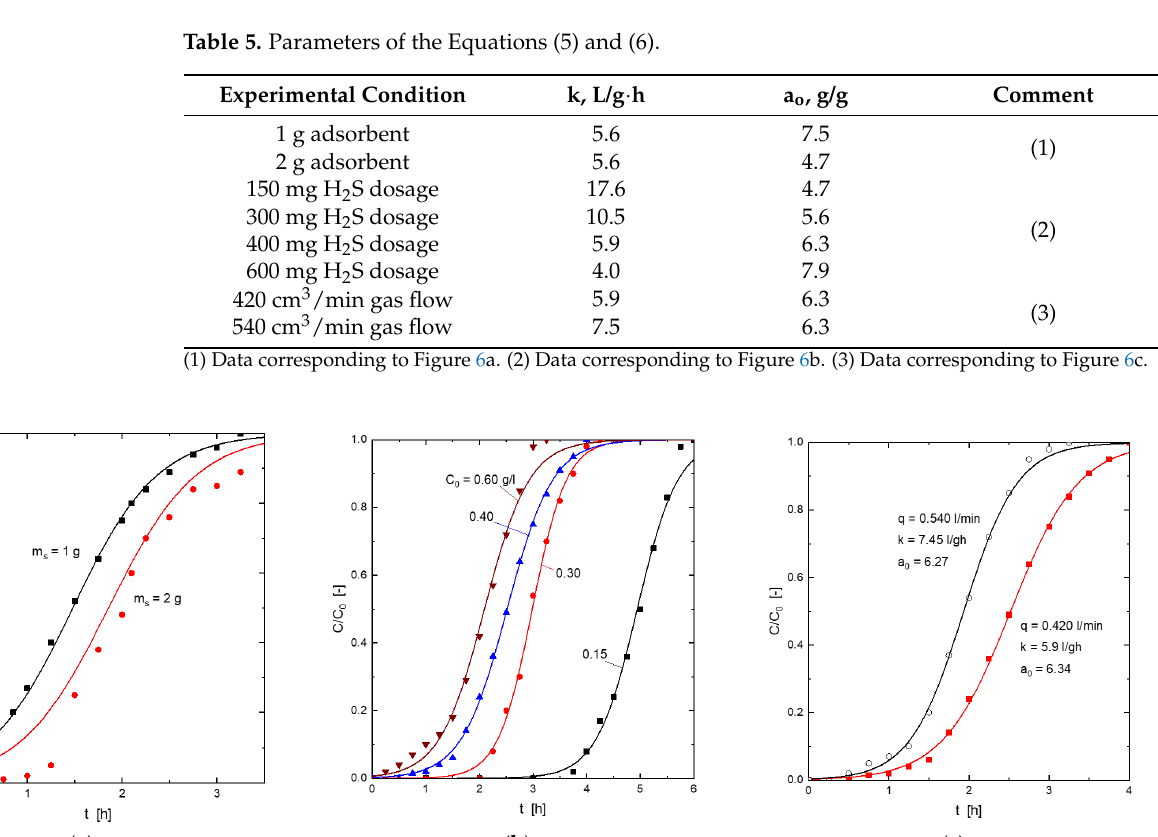
Table 5. Parameters of the Equations (5) and (6).